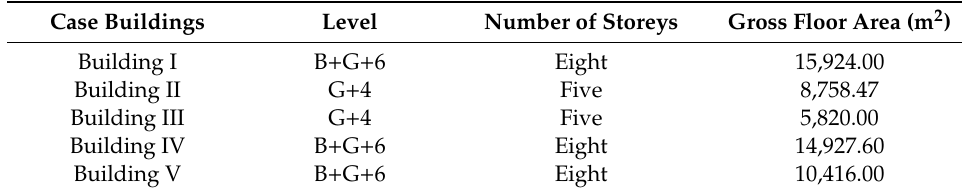
Table 1. The main characteristics of the case